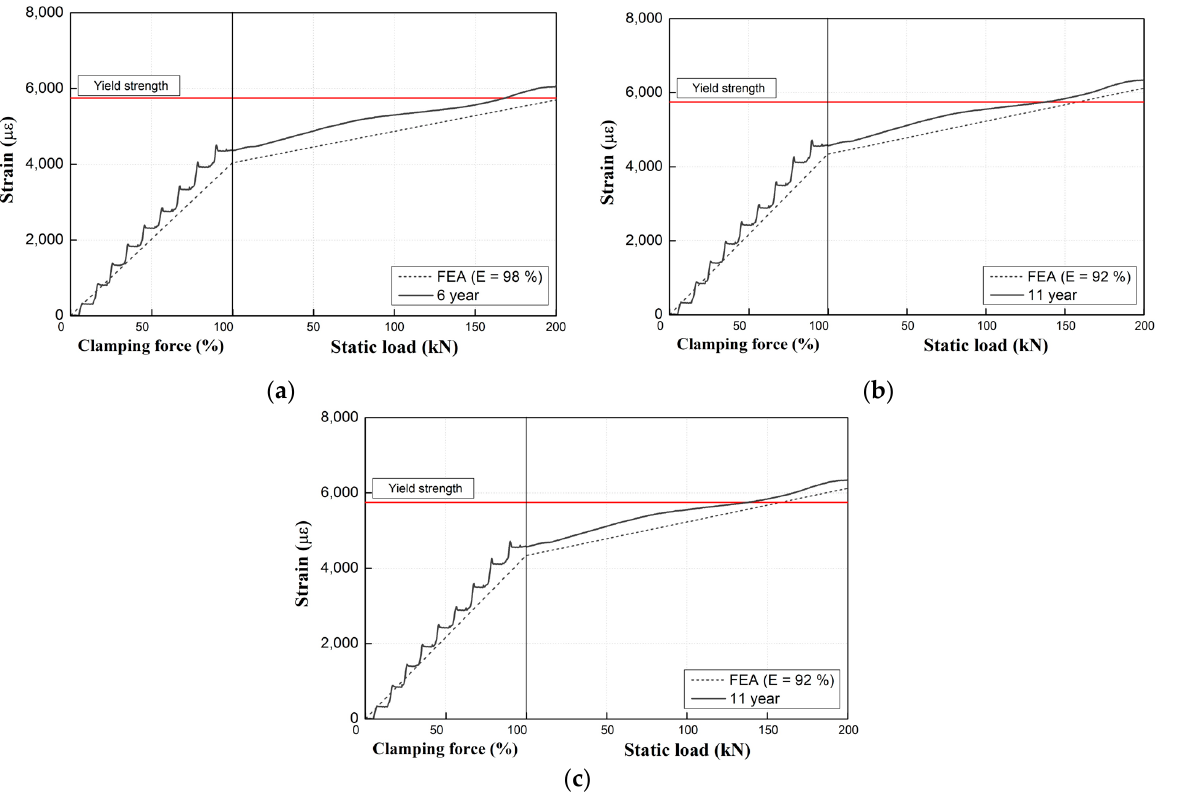
Figure 17. Comparison of analytical results with the measured Young’s moduli of tension clamps.